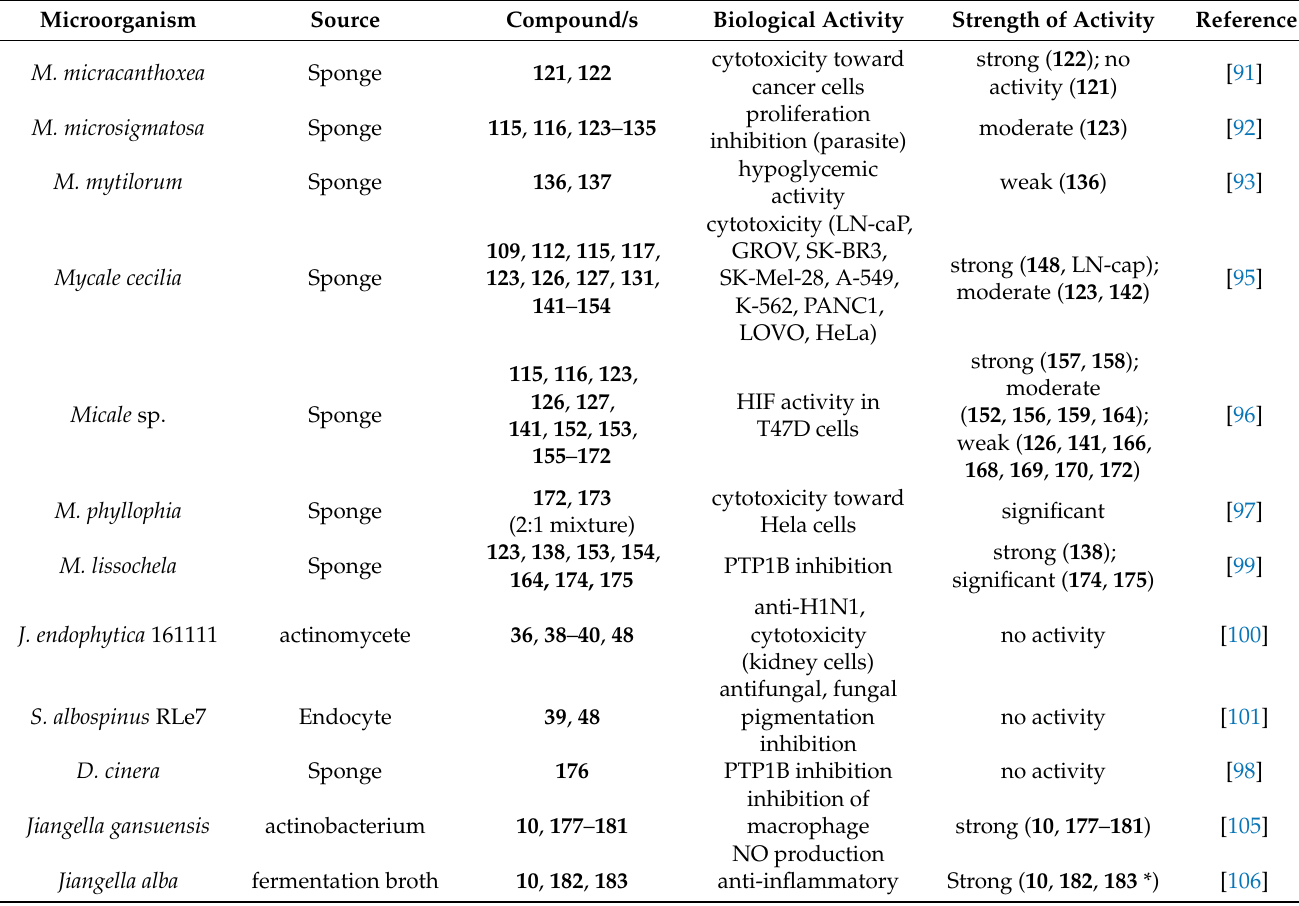
Table 3. Biological activity of compounds isolated from